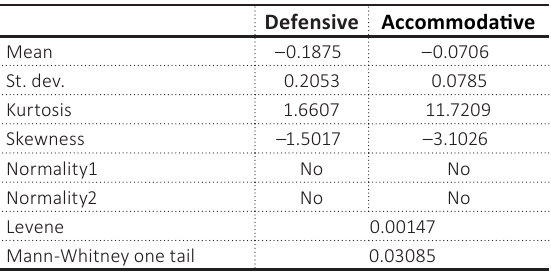
Table 1. All cases, CAR7. Descriptive statistics and statistical